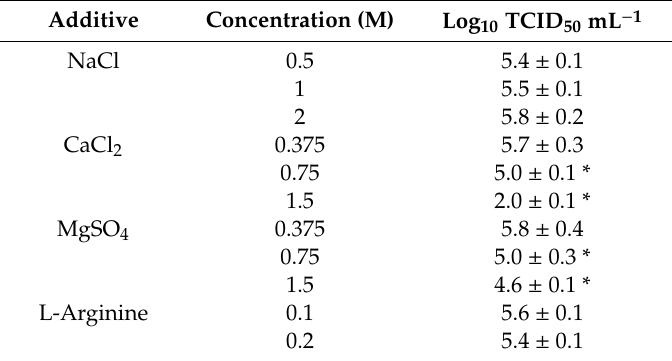
Table 3. Influence of di ff erent additives on the infectivity of MV. Data are means plus standard deviations of triplicates(* p <